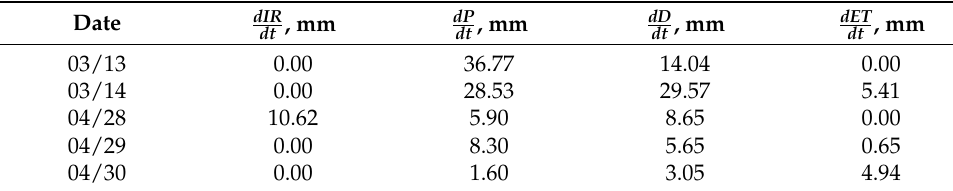
Figure 4. Soil water content and hydrologic variables obtained with the weighing lysimeter, ( a ) Soil water content and rainfall of March; ( b ) evapotranspiration ( 𝑑𝐸𝑇 𝑑𝑡 ⁄ ) and infiltration of March; ( c ) soil water content and rainfall of April; ( d ) dET dt ⁄ and infiltration of Abril. Table 2. Water balance of the days involved in determining the θ FC .